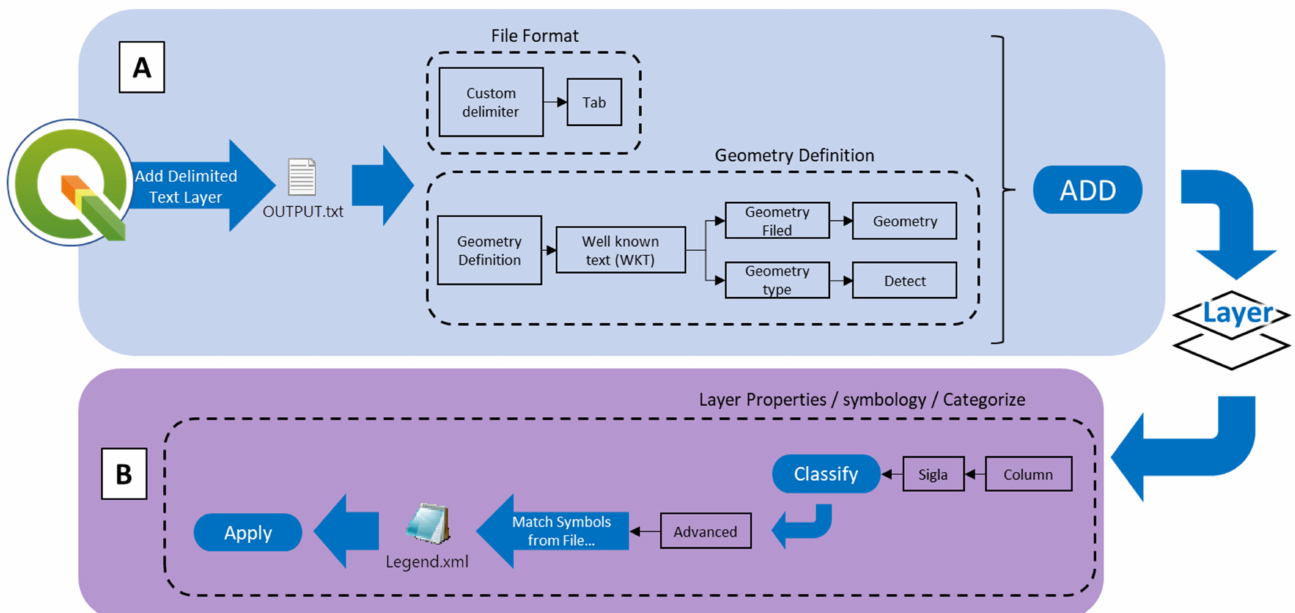
Figure 11. QGIS ( A ) “Add Delimited Text” import procedure, and ( B ) semi-automatic categoriza- tion